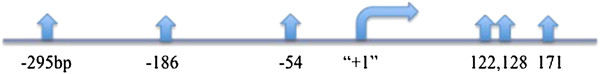
Diagrammatic representation of the IFN-γ promoter region [J00219: GenBank]. Vertical arrows indicate cytosine neighboring guanine (CpG) dinucleotide sequences that can be potentially methylated. The position of each CpG dinucleotide site is illustrated in relation to the transcription start, which is indicated as +1 bp (base pair).